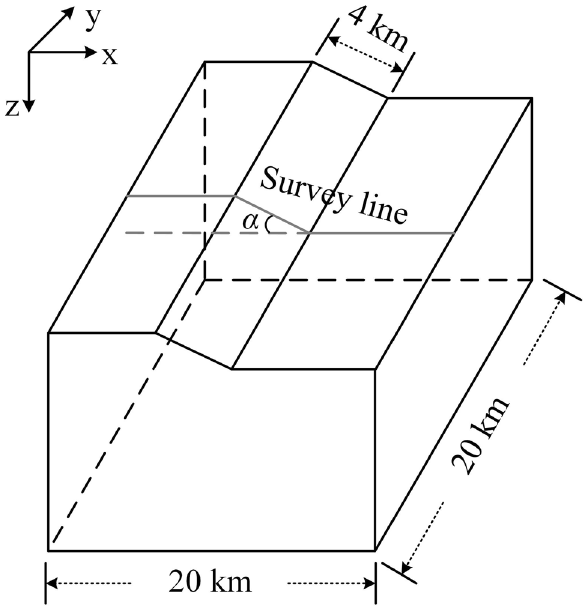
Figure 12. Sloped terrain models. The tilt angles of the slope are 10, 20, and 30